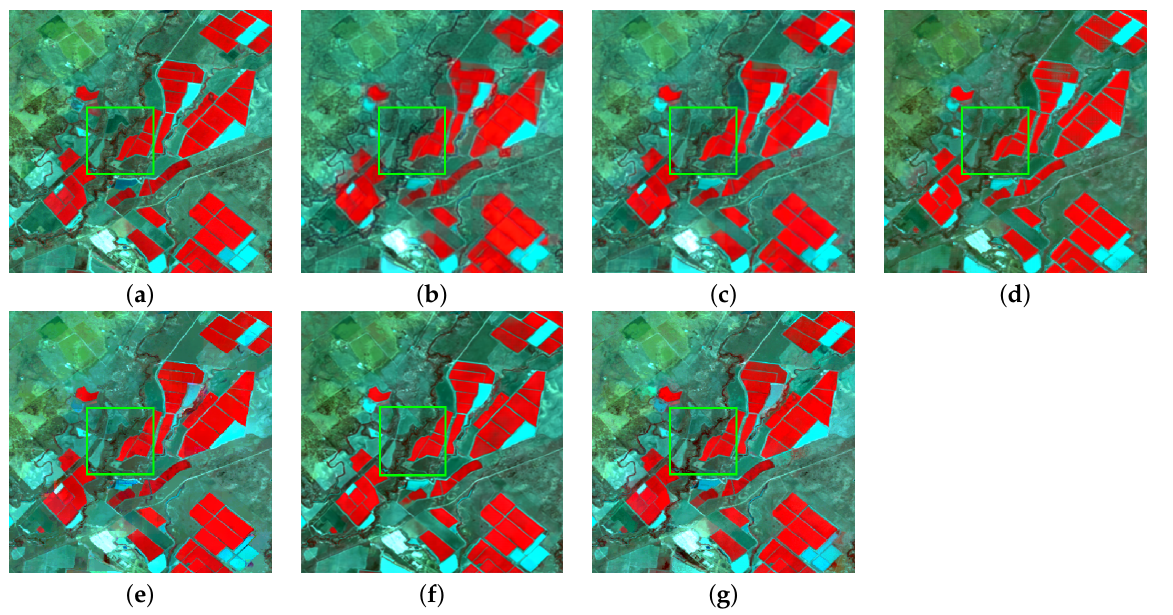
Figure 9. LGC dataset of real image acquired on 2 March 2005 and predicted images generated by each fusion method. ( a ) Observed. ( b ) STARFM. ( c ) FSDAF. ( d ) DCSTFN. ( e ) EDCSTFN. ( f ) AMNet. ( g ) Proposed